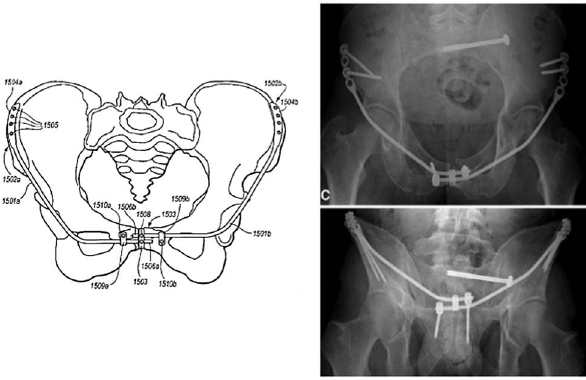
Figure 1. Parsells and Cole (2007) “ Pelvic Bridge.